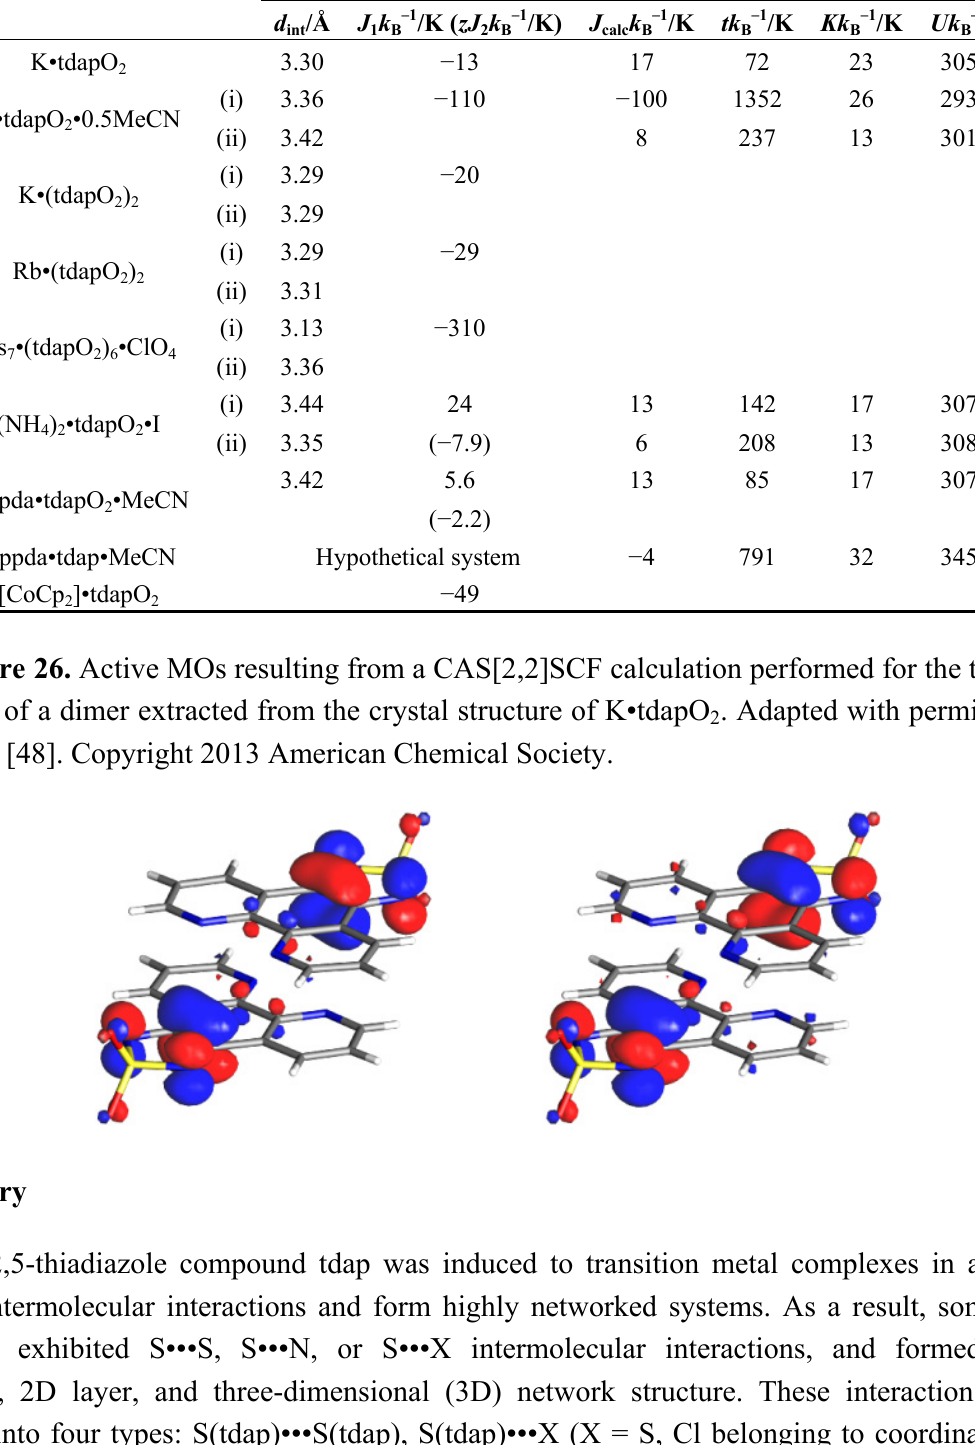
) and magnetic exchange coupling constants ( J and J ) int 1 2 and corresponding t , K , and U calc Experimental data